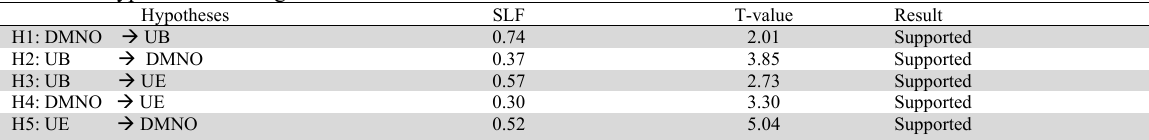
Results of Hypotheses